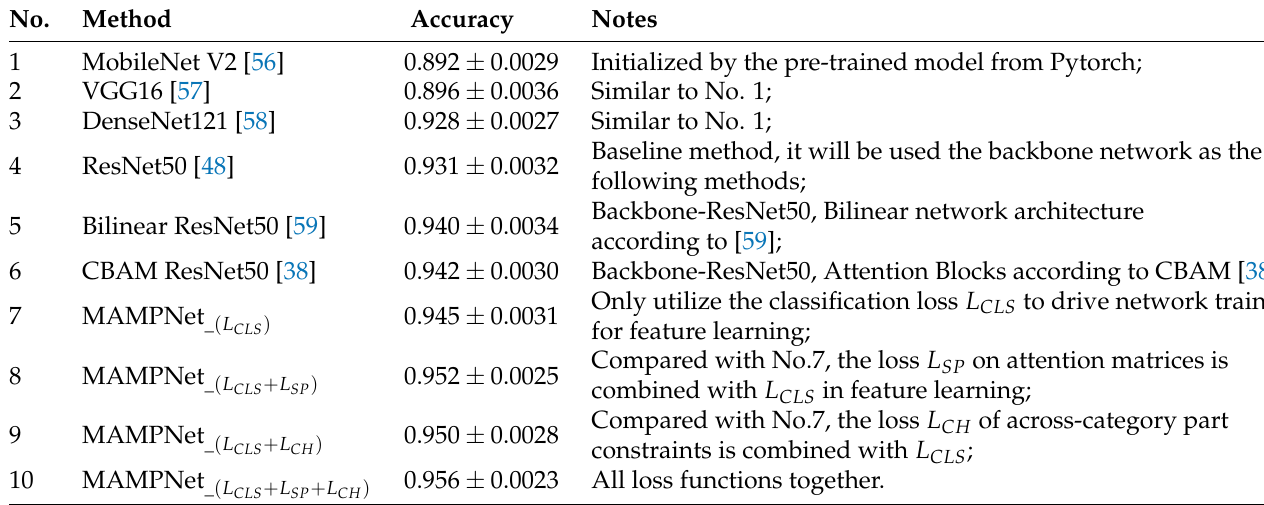
Table 4. Comparison with the related methods on the D 3 - Citrus flies . The methods used in No.7–10 indicate our algorithms learning features by the different combinations of three loss